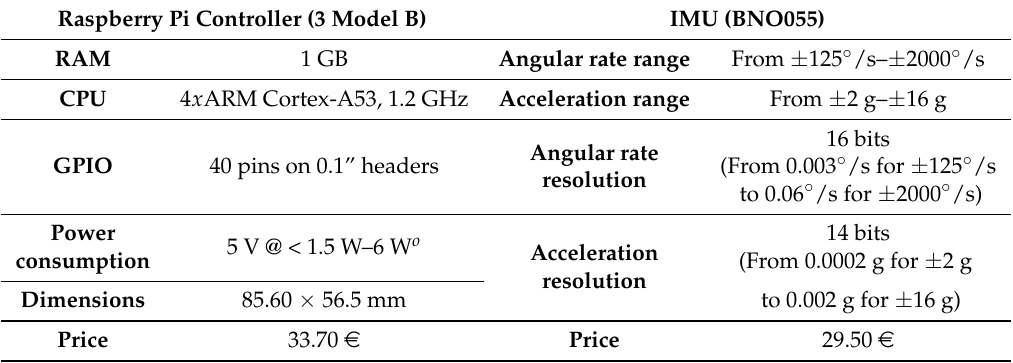
Table 2. Technical specifications of hardware elements included in the Raspberry Pi kit.